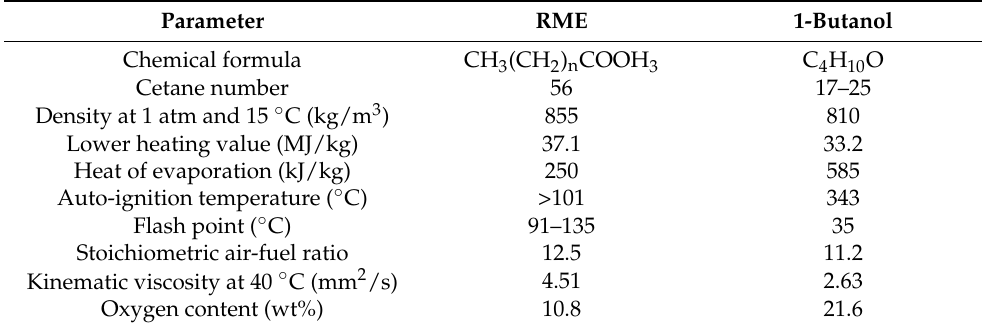
Table 3. Fuel specifications.